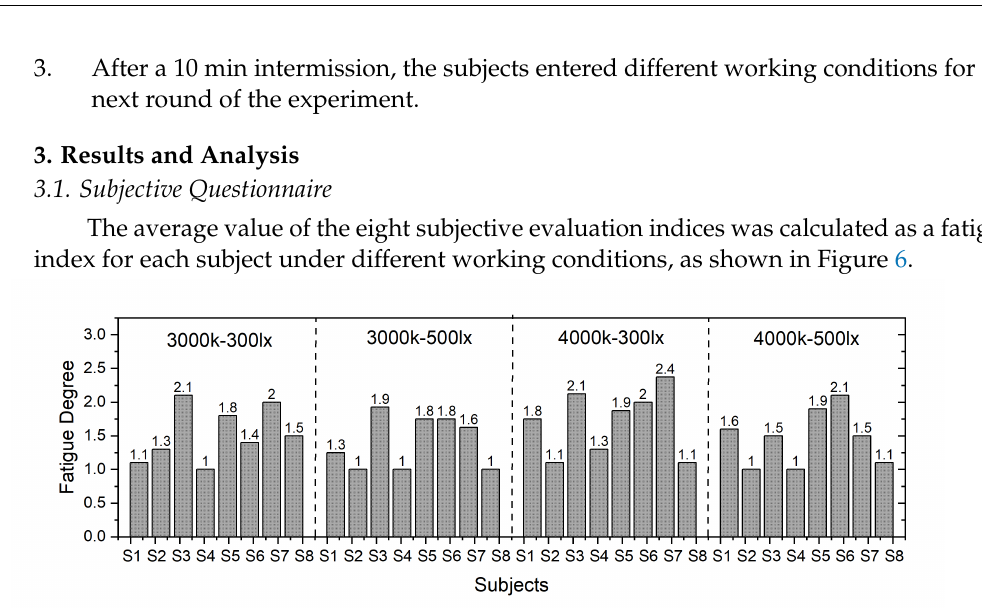
Figure 6. Subjective fatigue under different lighting